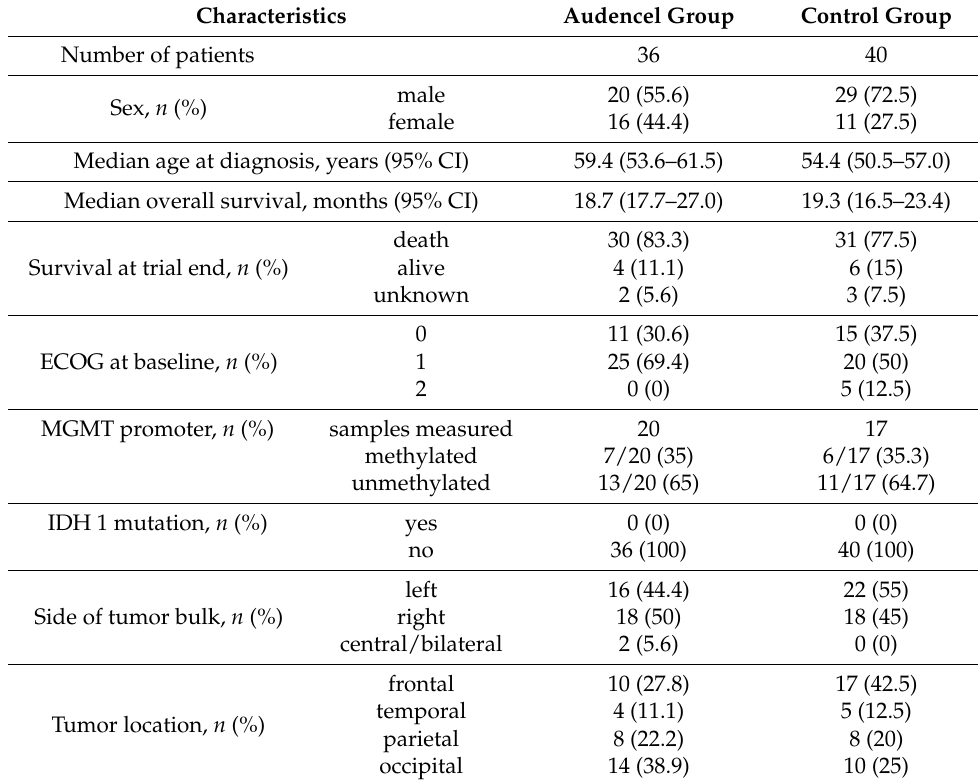
Table 2. Clinical and demographic information of the study